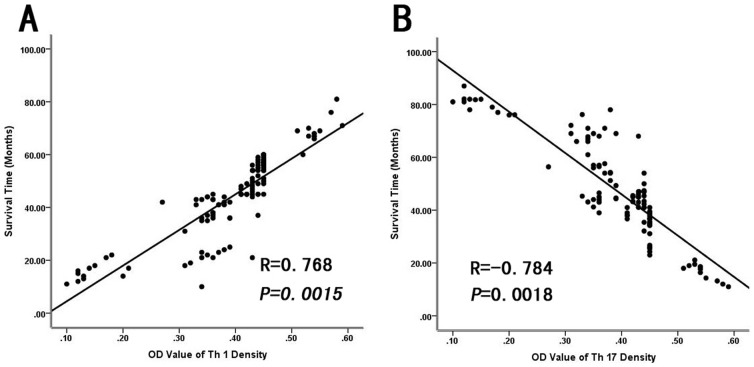
Correlation between levels of IL-17-producing cells, IFN-γ-producing cells, and prognosis for HCC.(A)Survival was inversely correlated to the optical density (OD) of intratumoral IL-17-producing cells (R = −0.784, P = 0.0018) and (B) positively correlated with the density of IFN-γ-producing cells (R = 0.768, P = 0.0015).